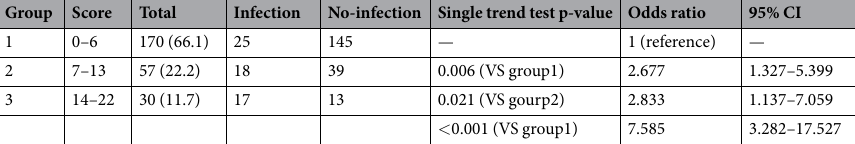
Table 7. Correlation of risk-stratification score with PPI. * VS: versus.